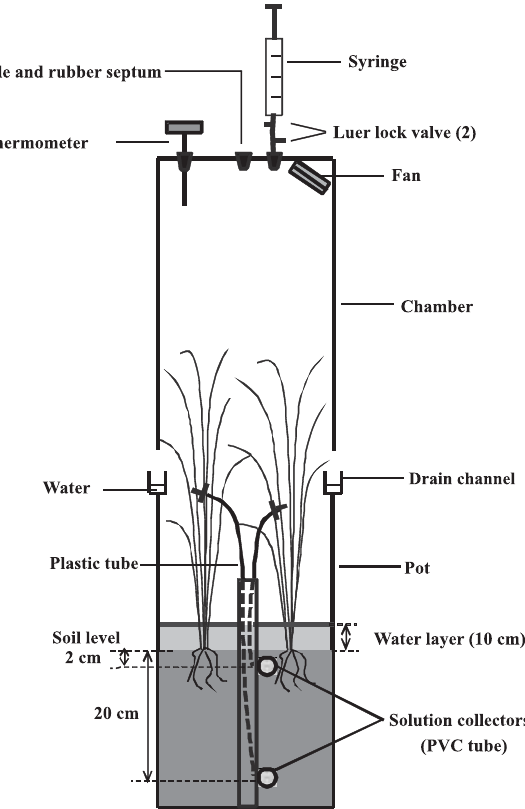
Figure 1. Closed chamber for air sampling and soil solution